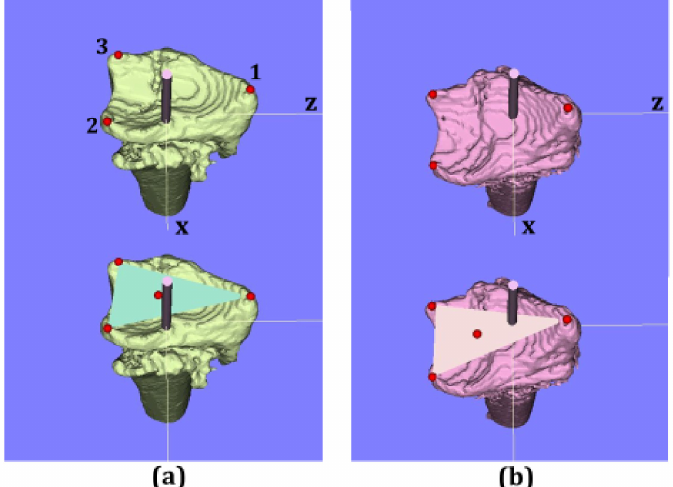
Figure 2. Axial view of 3D images. ( a ) Preoperative image, ( b ) postoperative image. Upper row images show three reference points. Lower row images show the barycentric coordinates of the plane connecting the three reference points. The red dots indicate radial styloid process: reference point (1), sigmoid notch volar edge: reference point (2), sigmoid notch dorsal edge: reference point (3), and the barycentric coordinates.